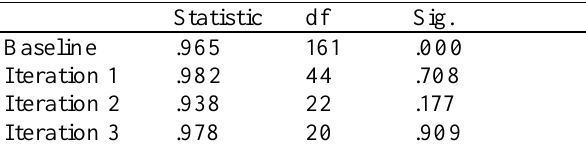
Shapiro-Wilk Test of Normality Statistic